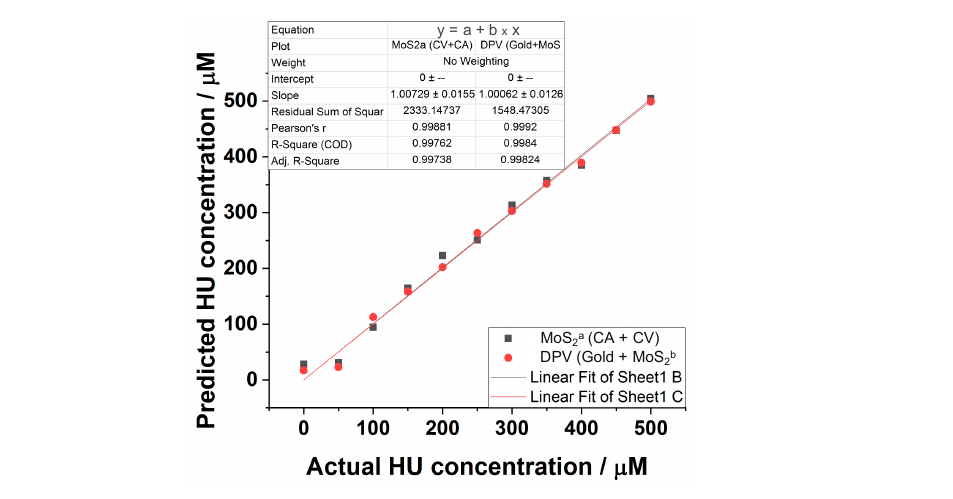
Figure S6: Representative charge transfer curves as a function of potential windows used for the electrodeposition of MoS2 on a commercial gold electrode; Figure S7: Nyquist plot of the bare and modified electrodes in the presence of ferro/ferricyanide solution (5 mM) in PBS solution pH 7.4; Figure S8: Superposition of the electrochemical signature of uric acid in PBS (plain traces) and in the simulated serum (dashed traces); Figure S9: Variable importance plot (VIP) for low (0–150 µ